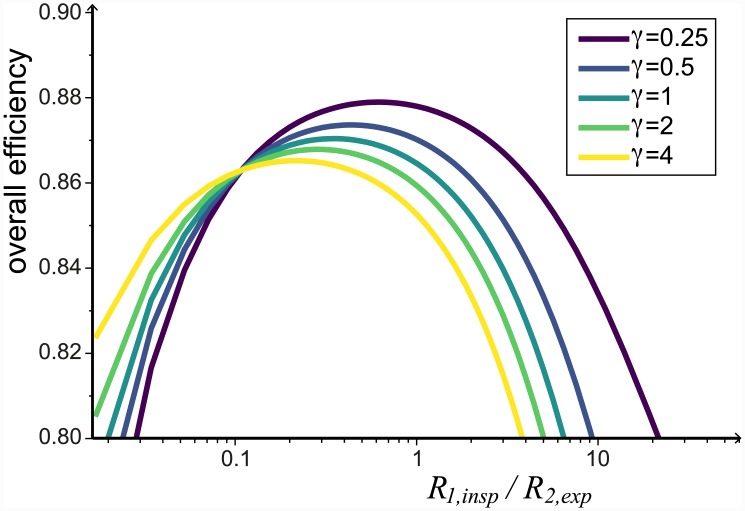
Changing the relative resistance of R1,insp / R2,exp affects the efficiency of the system.Plot of the overall efficiency when R1,insp / R2,exp is varied whilst keeping the total resistance of the system constant (R1,insp + R2,exp = 6 cmH2O/L⋅s). The effect is similar for a range of γ values. All other parameters are given in Table 1.